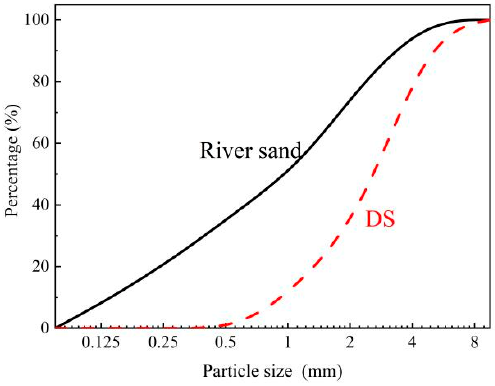
Figure 2. The particle size distribution curve. Table 1. The chemical compositions of the raw materials.